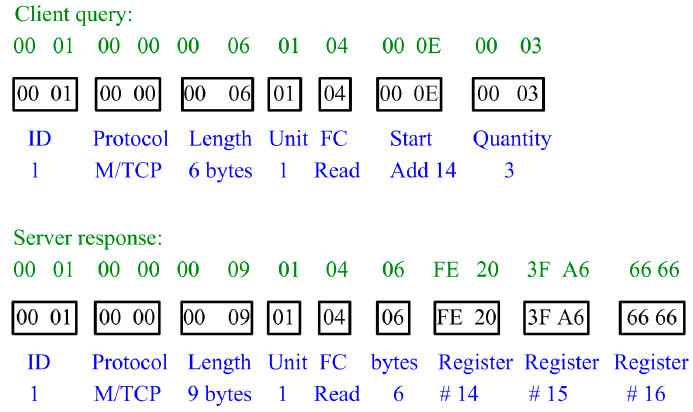
Figure 1. MODBUS query and response, an illustrative example.